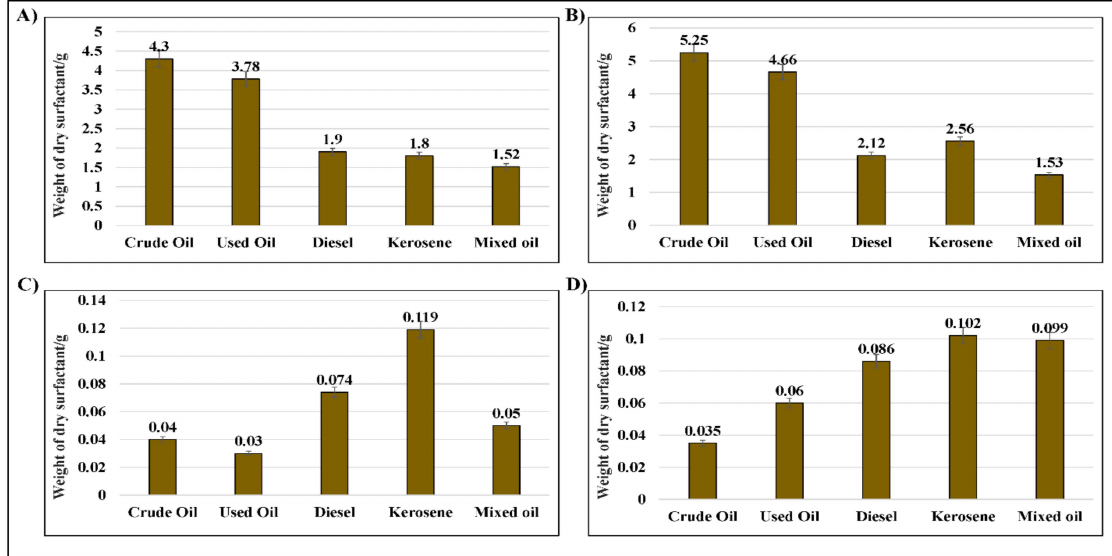
Figure 5. Bio-surfactant recovery assays of D. spicifera . ( A ) Acid precipitation, ( B ) solvent extraction, ( C ) ammonium sulfate, and ( D ) zinc sulfate precipitation